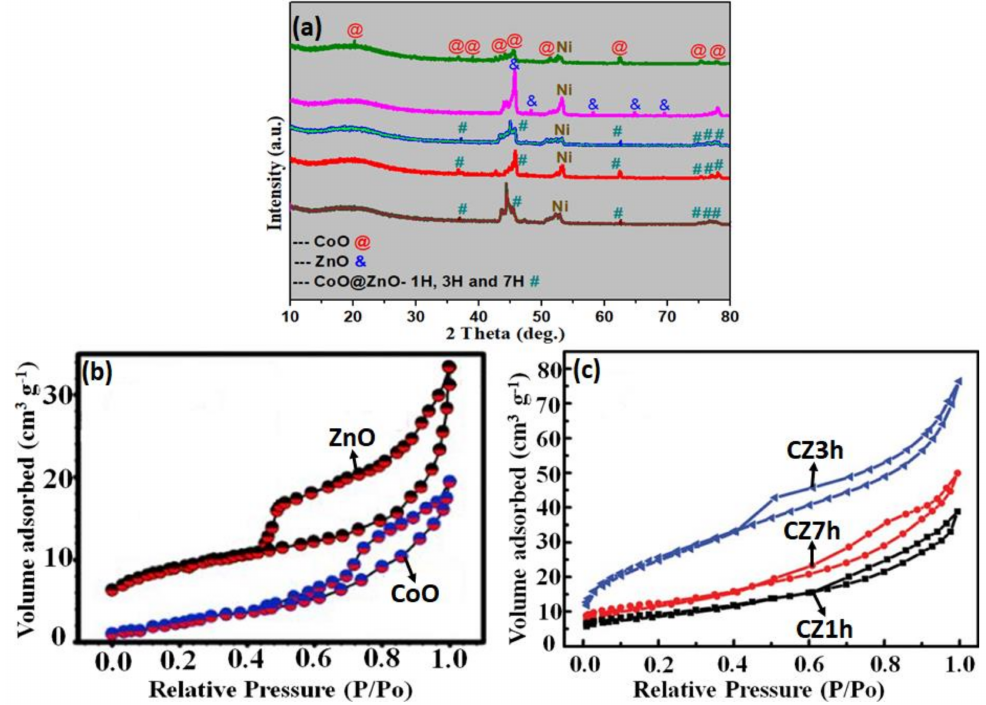
Figure 5. X-ray diffraction patterns (XRD) of all the samples. The Brunauer–Emmett–Teller (BET) surface area measured from nitrogen adsorption–desorption isotherms of ( b ) CoO and ZnO ( c ) CZ1h, CZ3h and CZ7h on Ni